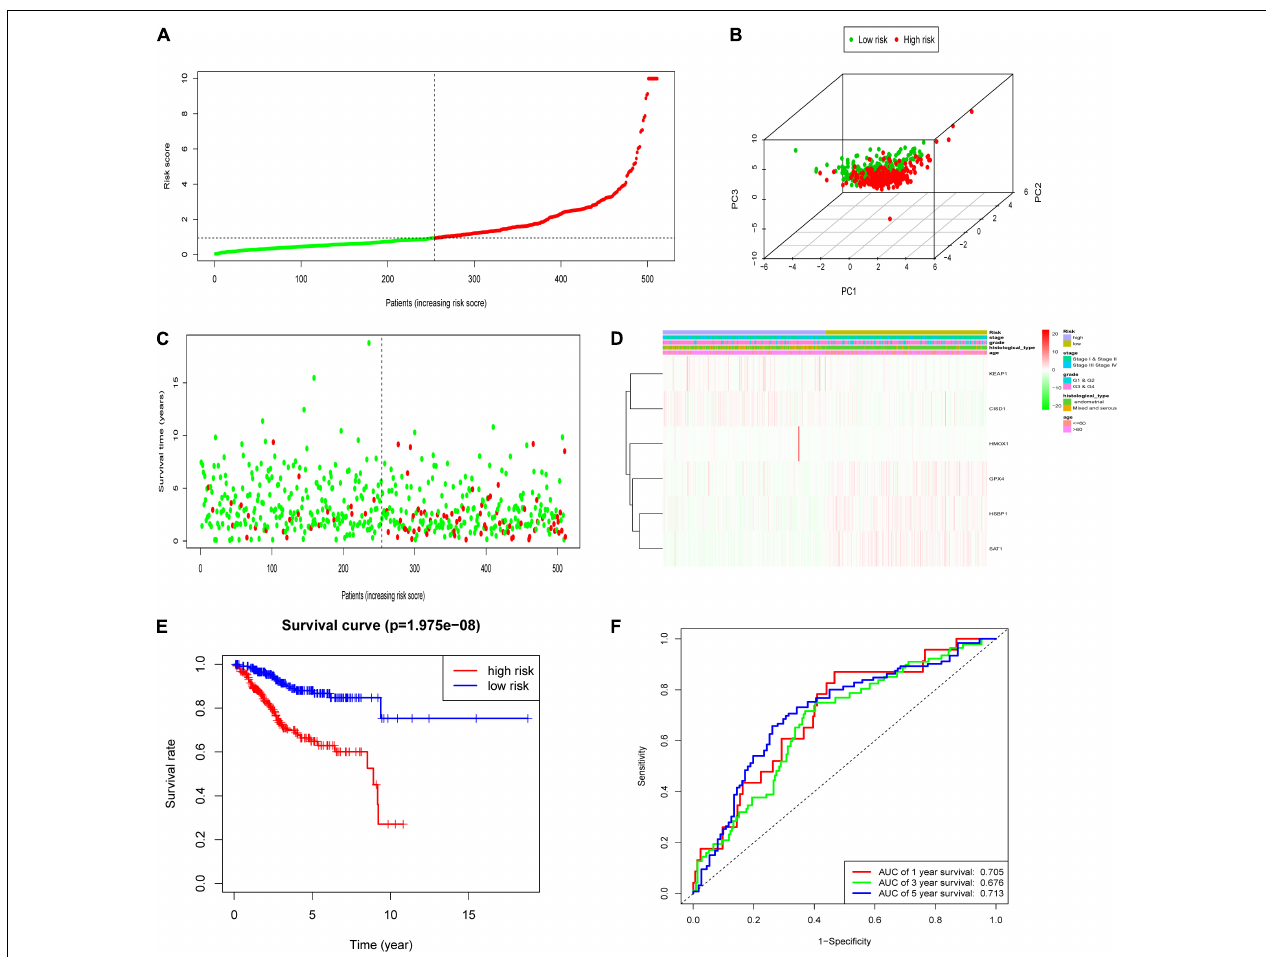
FIGURE 3 | Construction of the FRPS in the testing cohort. (A) The distribution of the risk score among patients. (B) PCA analysis confirmed that patients in two subgroups were distributed in discrete directions. (C) The distribution of the survival status among patients. (D) The distribution of stage, grade, histological type, age, and the expression of six genes in high-risk and low-risk groups. (E) Kaplan–Meier survival curves of overall survival between high-risk and low-risk patients in testing set. (F) 1-year, 3-year, and 5-year ROC curve of the predictive power of the FRPS in testing set.